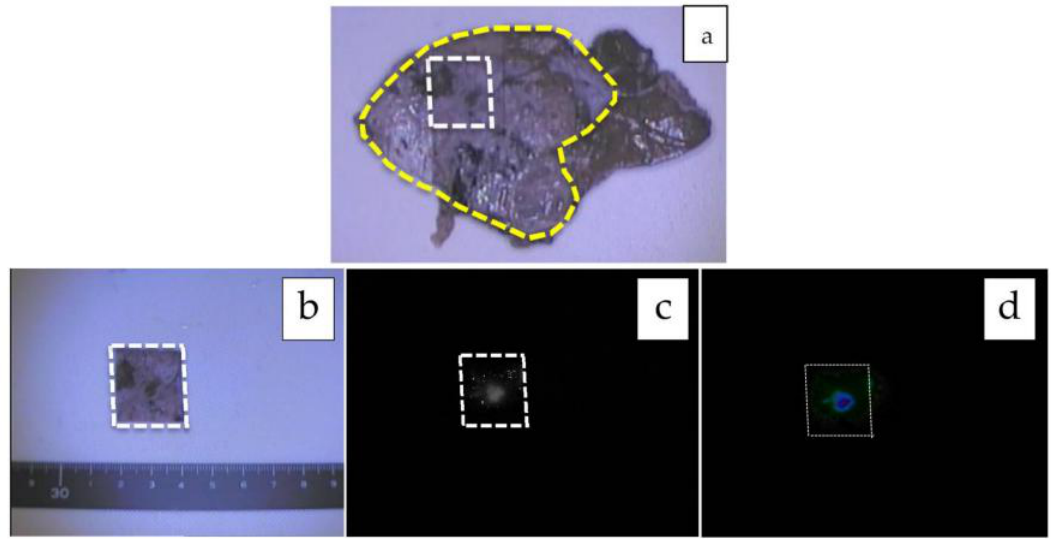
Figure 2. a , b : The hilum of the liver in Patient 12. A giant tumor with uneven fluorescence in the left lobe along with intrahepatic metastasis (di ff use pattern) is indicated by an arrowhead. Of note, the common bile duct is also visualized, presumably due to residual fluorescence, indicated by an arrow (mixed epithelial and mesenchymal,